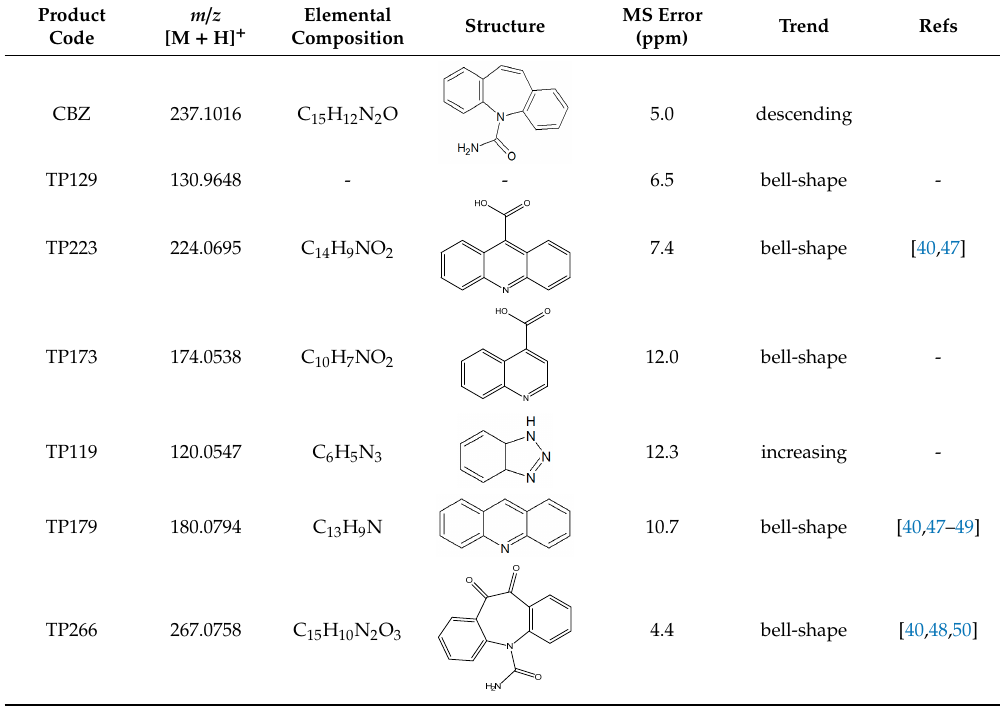
Table 2. Transformation products of carbamazepine by photoelectrocatalysis.